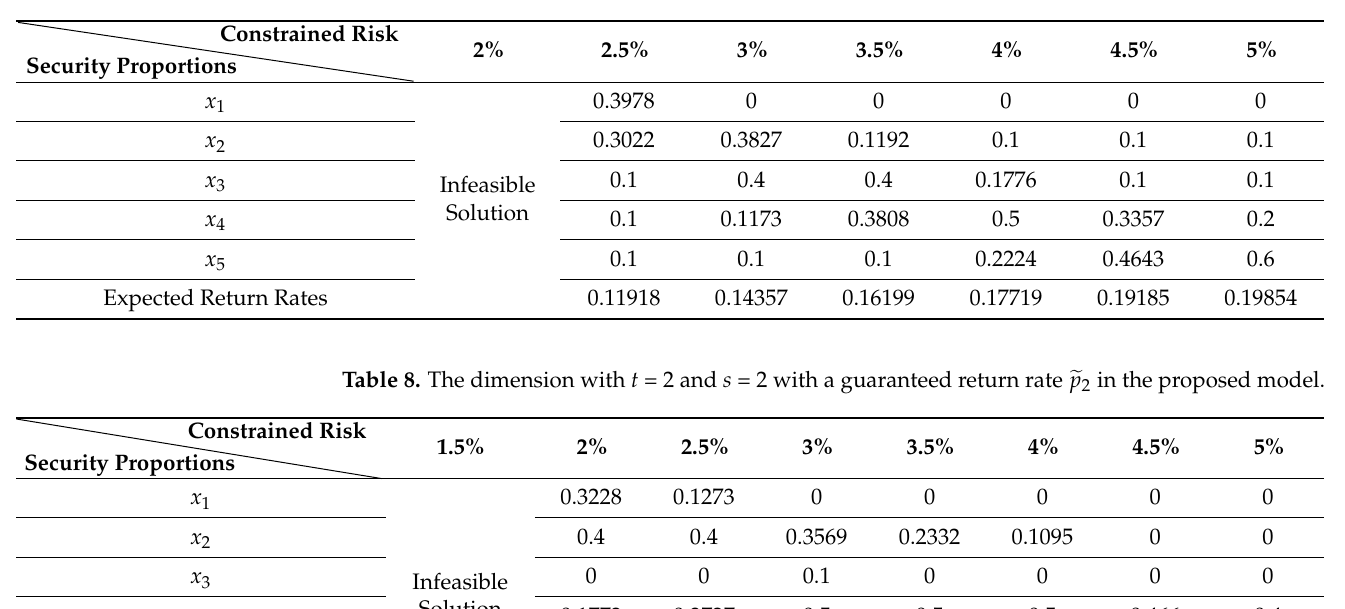
Table 7. The dimension with t = 2 and s = 2 with a guaranteed return rate (cid:101) p 1 in the proposed model.